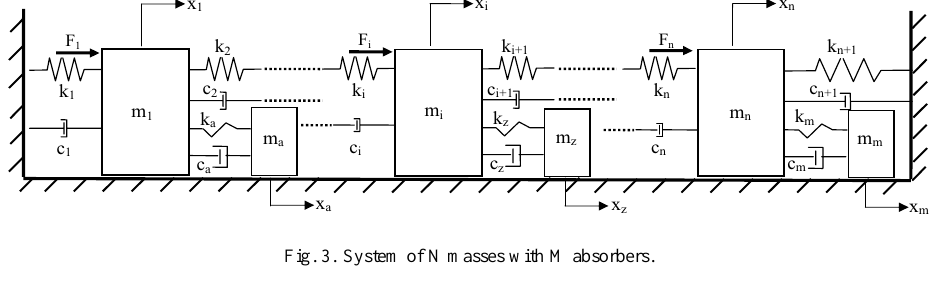
Fig. 3. System of N masses with M absorbers.